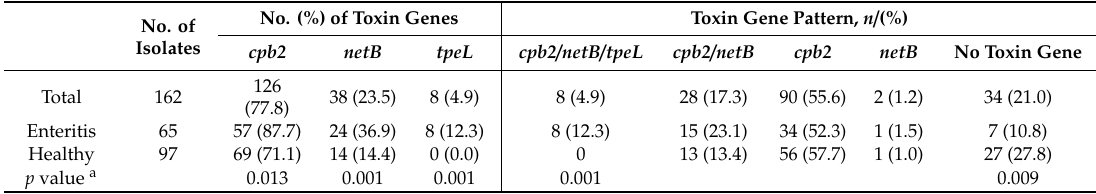
Table 3. Toxingeneprevalencein Clostridiumperfringens